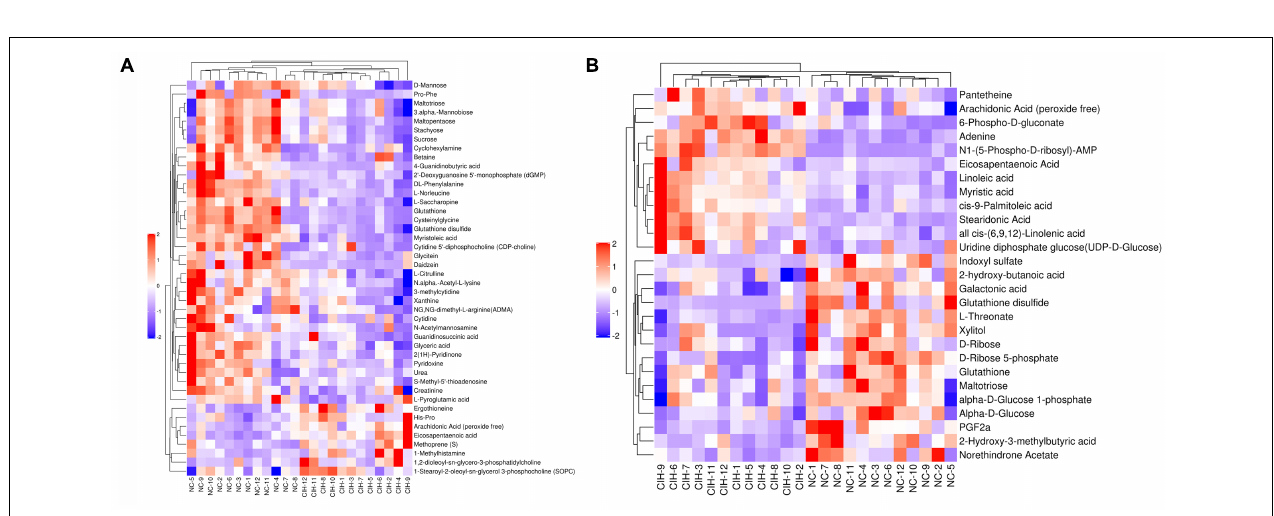
FIGURE 4 | The metabolite heatmaps between NC and control group (A) negative ion mode; (B) positive ion mode.